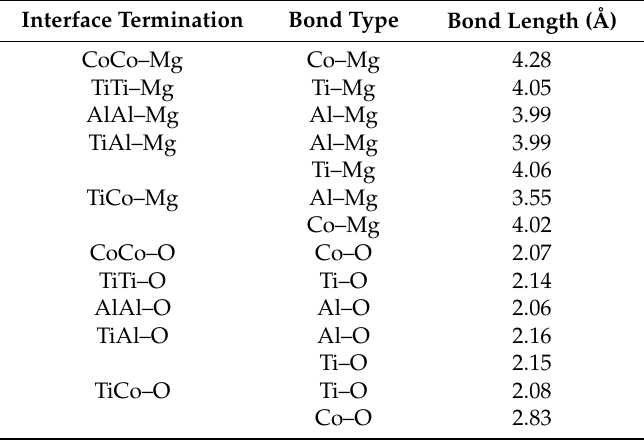
Table 1. Bond lengths at the